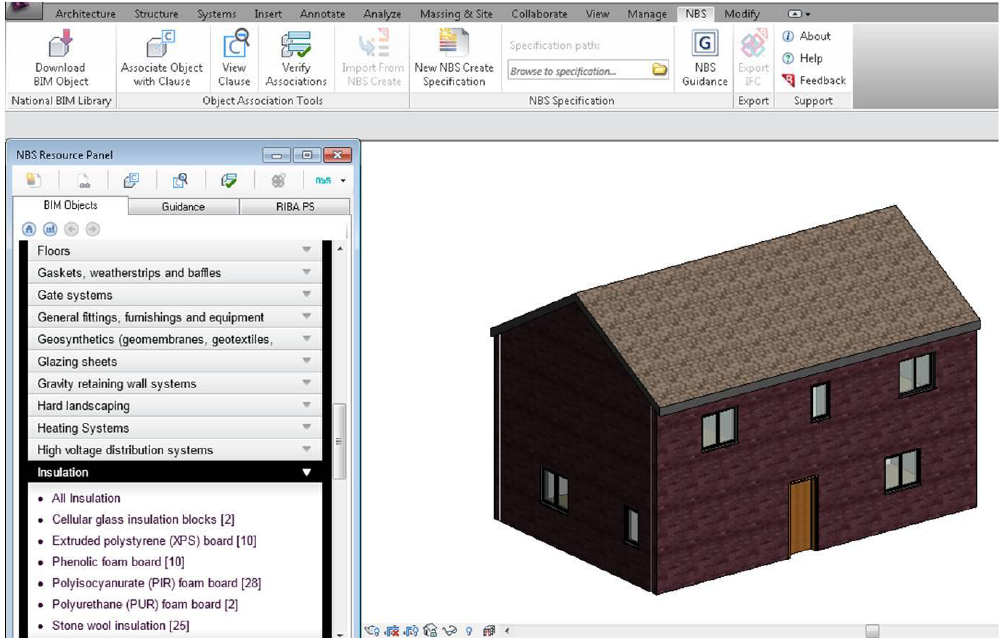
Figure 5. External wall insulation demonstration in